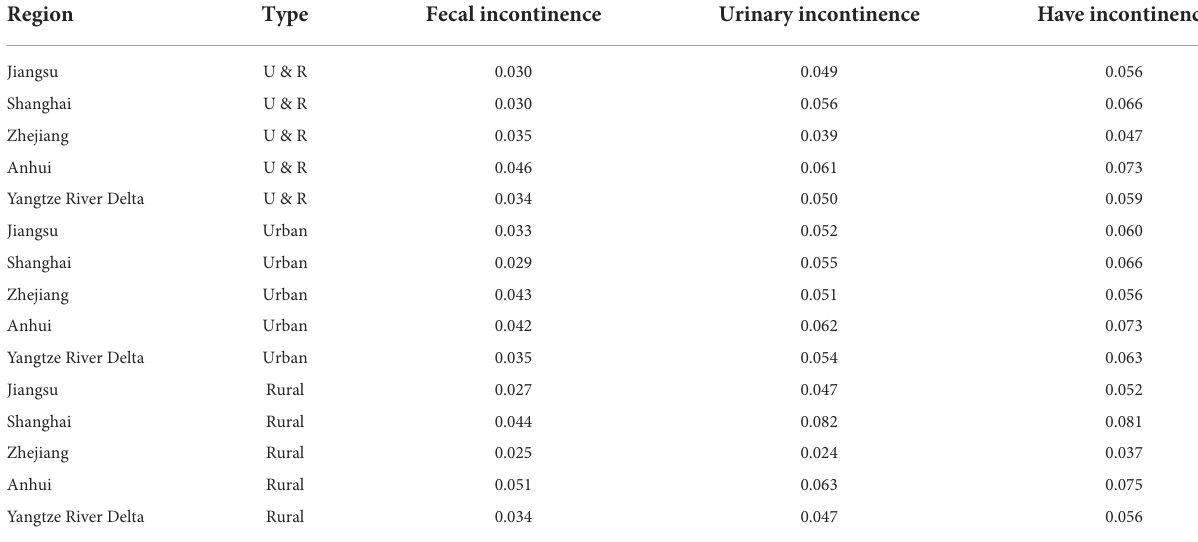
TABLE 5 Coefficient of variation of incontinence index